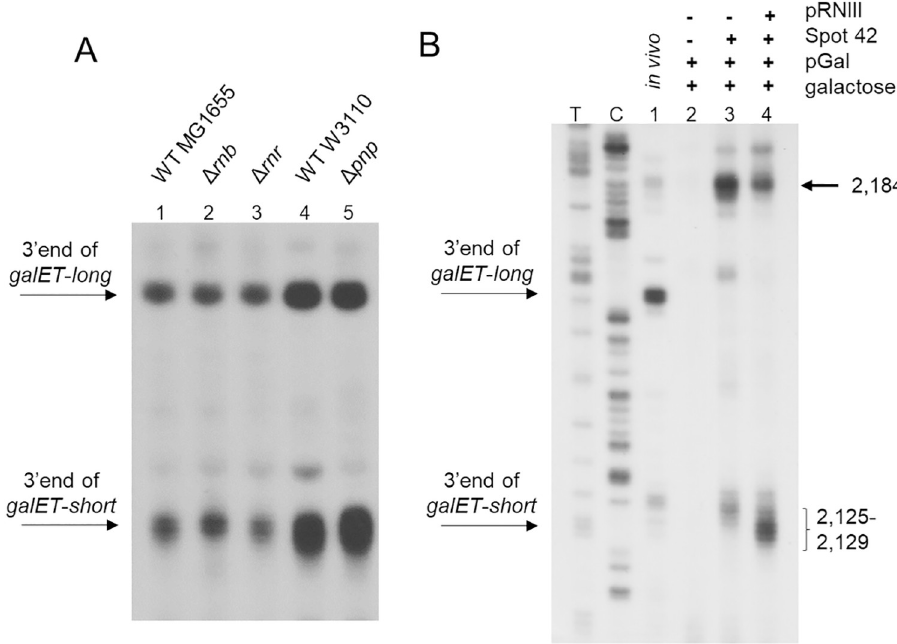
Fig 5. Generation of galET-short 3’ ends by RNase III-mediated transcript cleavage. A) 3’RACE assay of galET 3’ends in E . coli mutants that are deficient in exoribonucleases. Strains used are MG1655 Δ rnb (where the gene for RNase II is deleted from the chromosome) (lane 2), MG1655 Δ rnr (where the gene for RNase R is deleted from the chromosome) (lane 3), W3110 Δ pnp (where the gene for PNPase is deleted from the chromosome) (lane 5). The results of the WT for strains Δ rnb and Δ rnr are shown in lane 1, and for Δ pnp strain is shown in lane 4. B) 3’RACE assay of the galET mRNA from the cell-free system in presence of pRNIII plasmid, where the gene for RNase III is under control of the T7 promoter. The data presented in these blots are representative of three independent experiments.